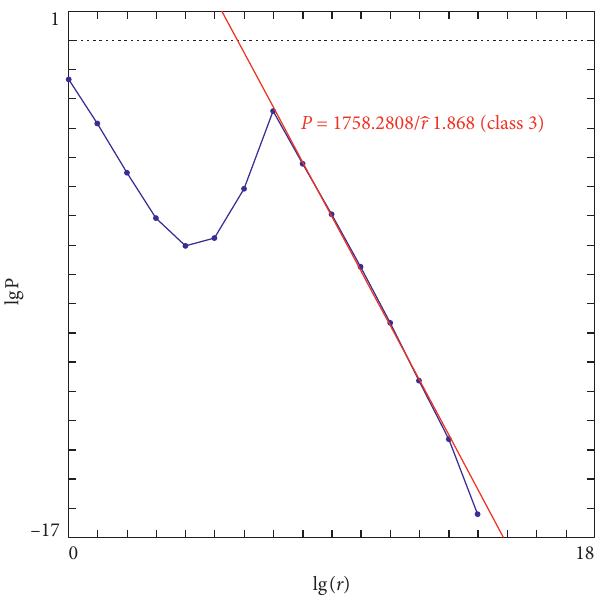
� 0 (a) and along the plane x 3